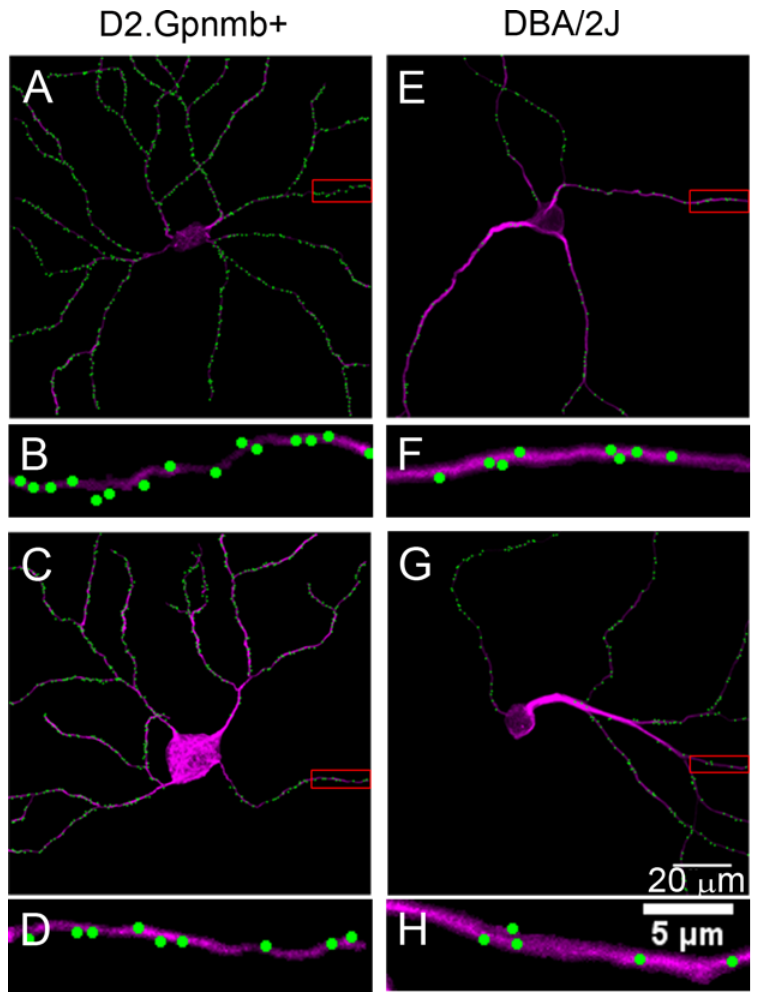
Fig 4. Labeling of synaptic inputs to ganglion cells in glaucomatous DBA/2J retinas. A, Digital representation of a non-glaucomatous (D2.Gpnmb+) retina. B, Higher magnification of the boxed area in panel A, showing the density of excitatory synaptic inputs to a higher-order dendrite. C & E, Two examples of ganglion cells from glaucomatous DBA/2J mice. The dendritic remodeling is obvious. D & F, Higher magnification views of the boxed areas in panels C and E, respectively. Overall synaptic density is lower than in the non-glaucomatous ganglion cells.